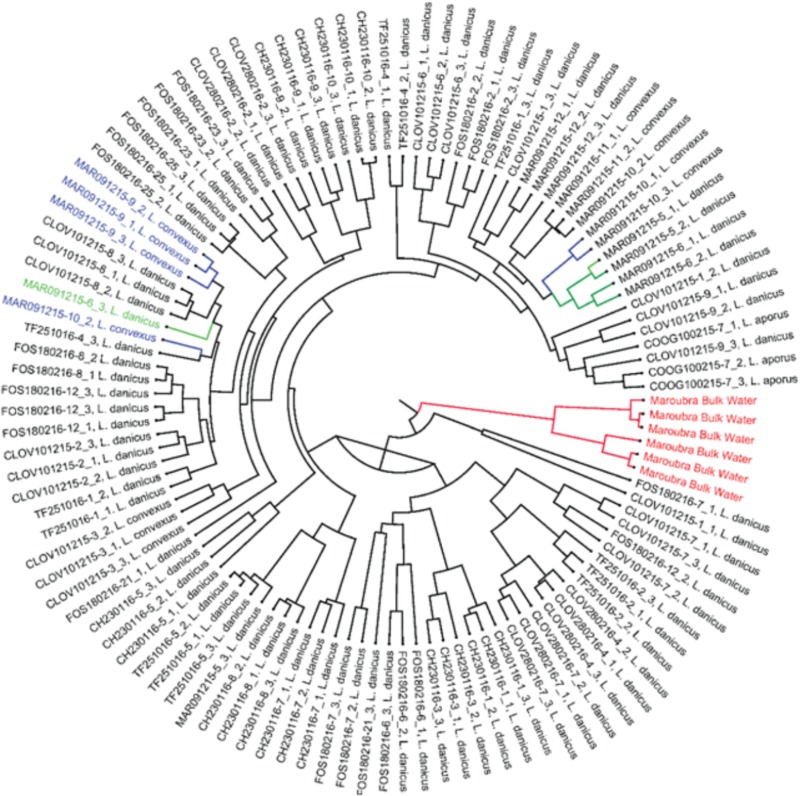
Jack knife phylogeny based on the weighted rarefied data shows Maroubra bulk water samples (shown in red) clearly separated from other bacterial communities associated with the diatom Leptocylindrus isolated from the same location. Green: bacterial communities associated with Leptocylindrus danicus; blue: bacterial communities associated with Leptocylindrus convexus.